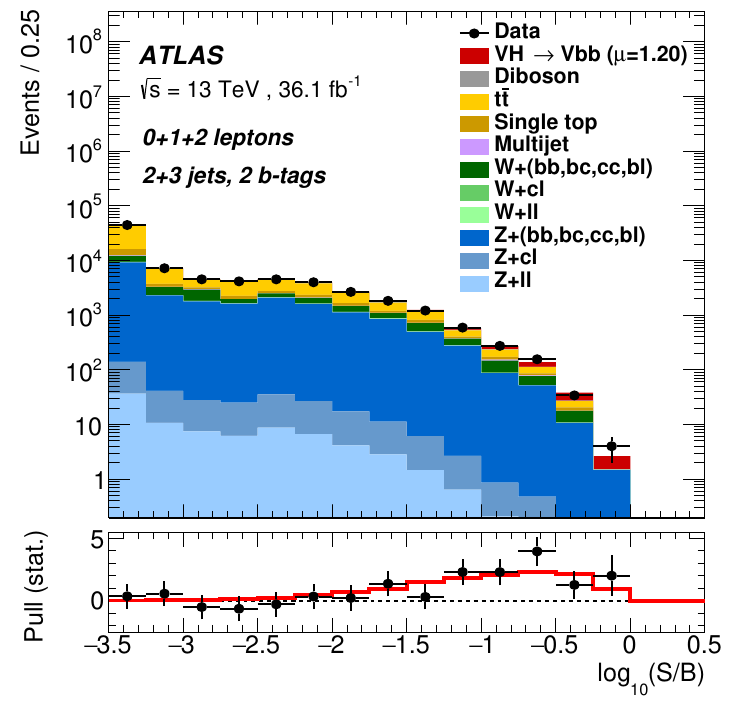
Figure 6 . Event yields as a function of log( S=B ) for data, background and a Higgs boson signal with m H = 125 GeV. Final-discriminant bins in all regions are combined into bins of log( S=B ), with the (cid:12)tted signal being S and the (cid:12)tted background B . The Higgs boson signal contribution is shown after rescaling the SM cross-section according to the value of the signal strength parameter extracted from data ( (cid:22) = 1 : 20). The pull (residual divided by its uncertainty) of the data with respect to the background-only prediction is also shown with statistical uncertainties only. The full line indicates the pull of the prediction for signal ( (cid:22) = 1 : 20) and background with respect to the background-only